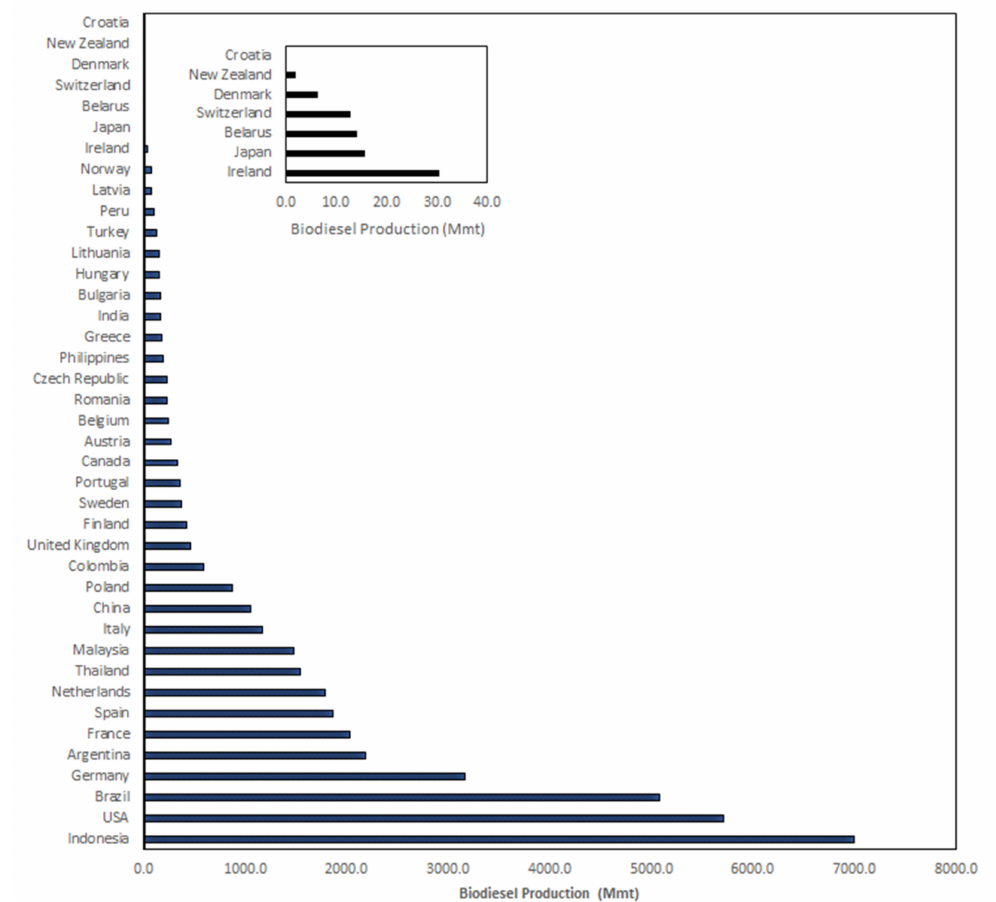
Figure 7. The production of biodiesel contributed by each country in 2019 Reproduced with permission from Coyle, The future of biofuels: a global perspective, Amber Waves